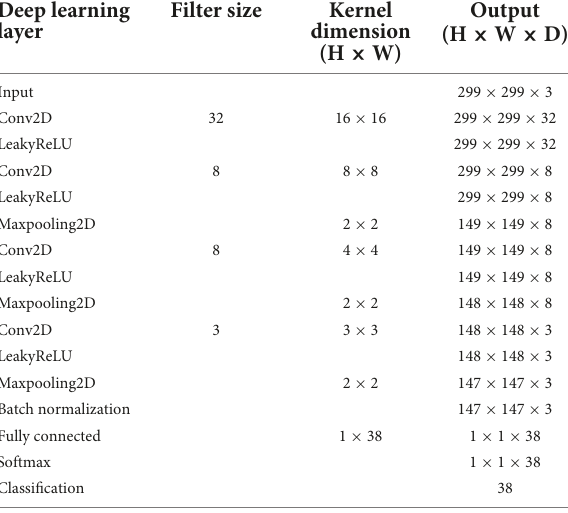
TABLE 1 Deep learning layers and their specifications.